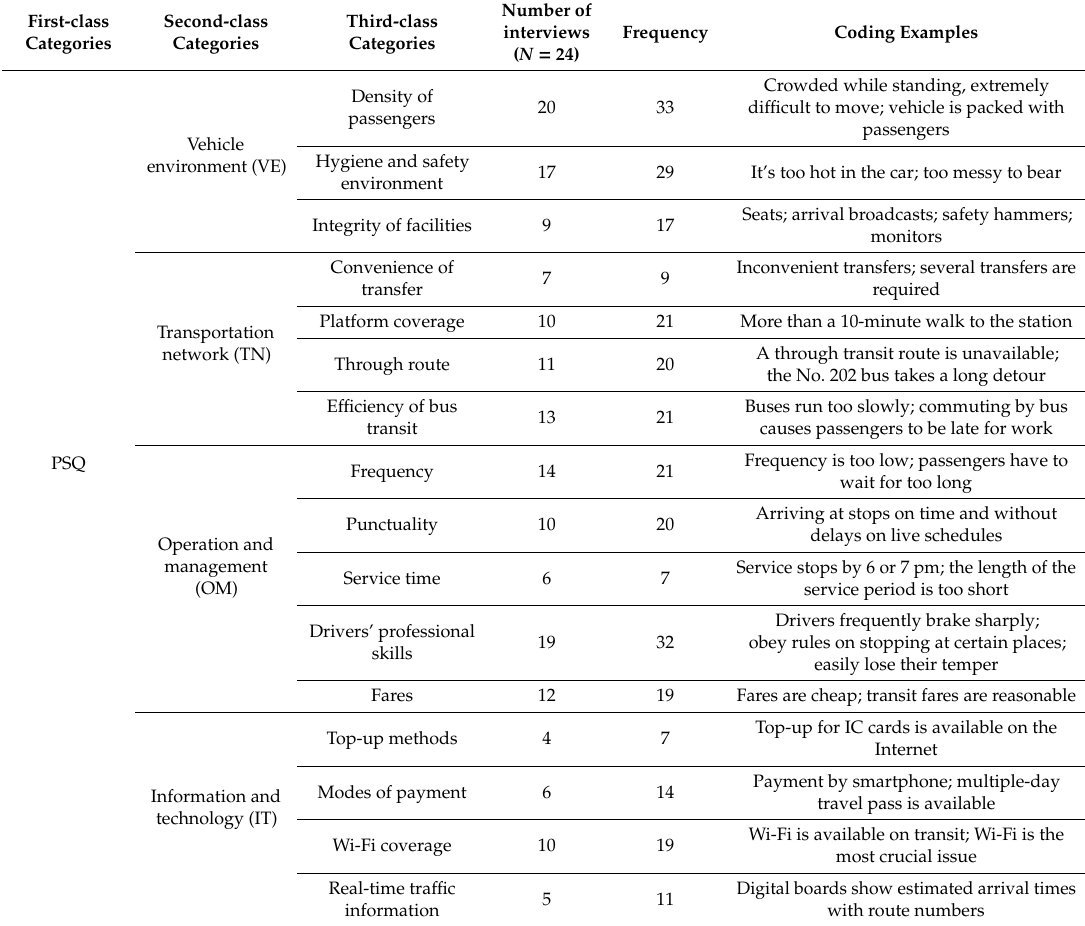
Table A1. Coding results of interview data of 27 interviewees (23 individuals and 4 in a